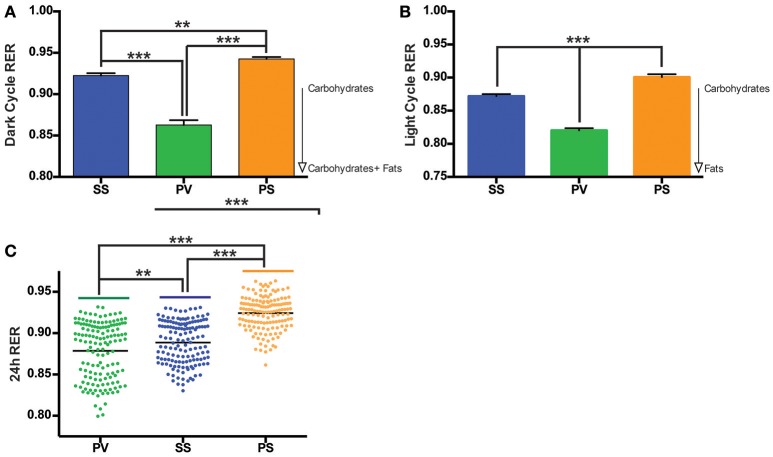
Bilateral subdiaphragmatic vagotomy lowers respiratory exchange ratio (RER) in fully obese Mc4r−/− mice. (A,B) Bar graphs of the mean RER, n = 5–8 per treatment group during the dark cycle (averaged into 100 min bins to reduce clutter) and light cycle respectively. (C) Vertical dot plot of 24 h RER with mean (black bar). RER data was sampled at consecutive 10-min intervals over the course of the monitoring period. **p < 0.01, ***p < 0.001 criterion for statistical significance.